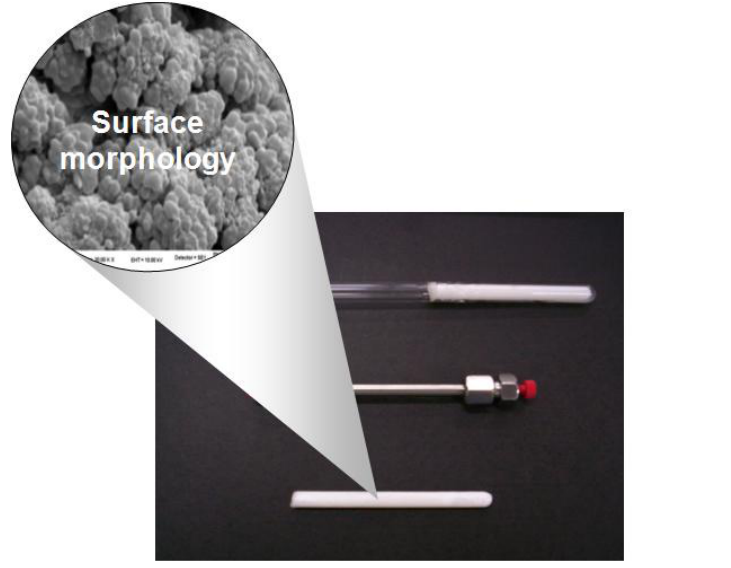
Figure 3. Macroporous monolithic rods prepared in a glass tube and a column of stainless steel